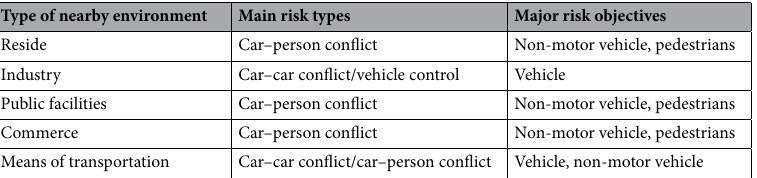
Table 2. This table mainly describes the types of accessories, main risk types and main risk objectives. The nearby types are divided into residence, industrial land, etc., the main risk types are divided into vehicle person